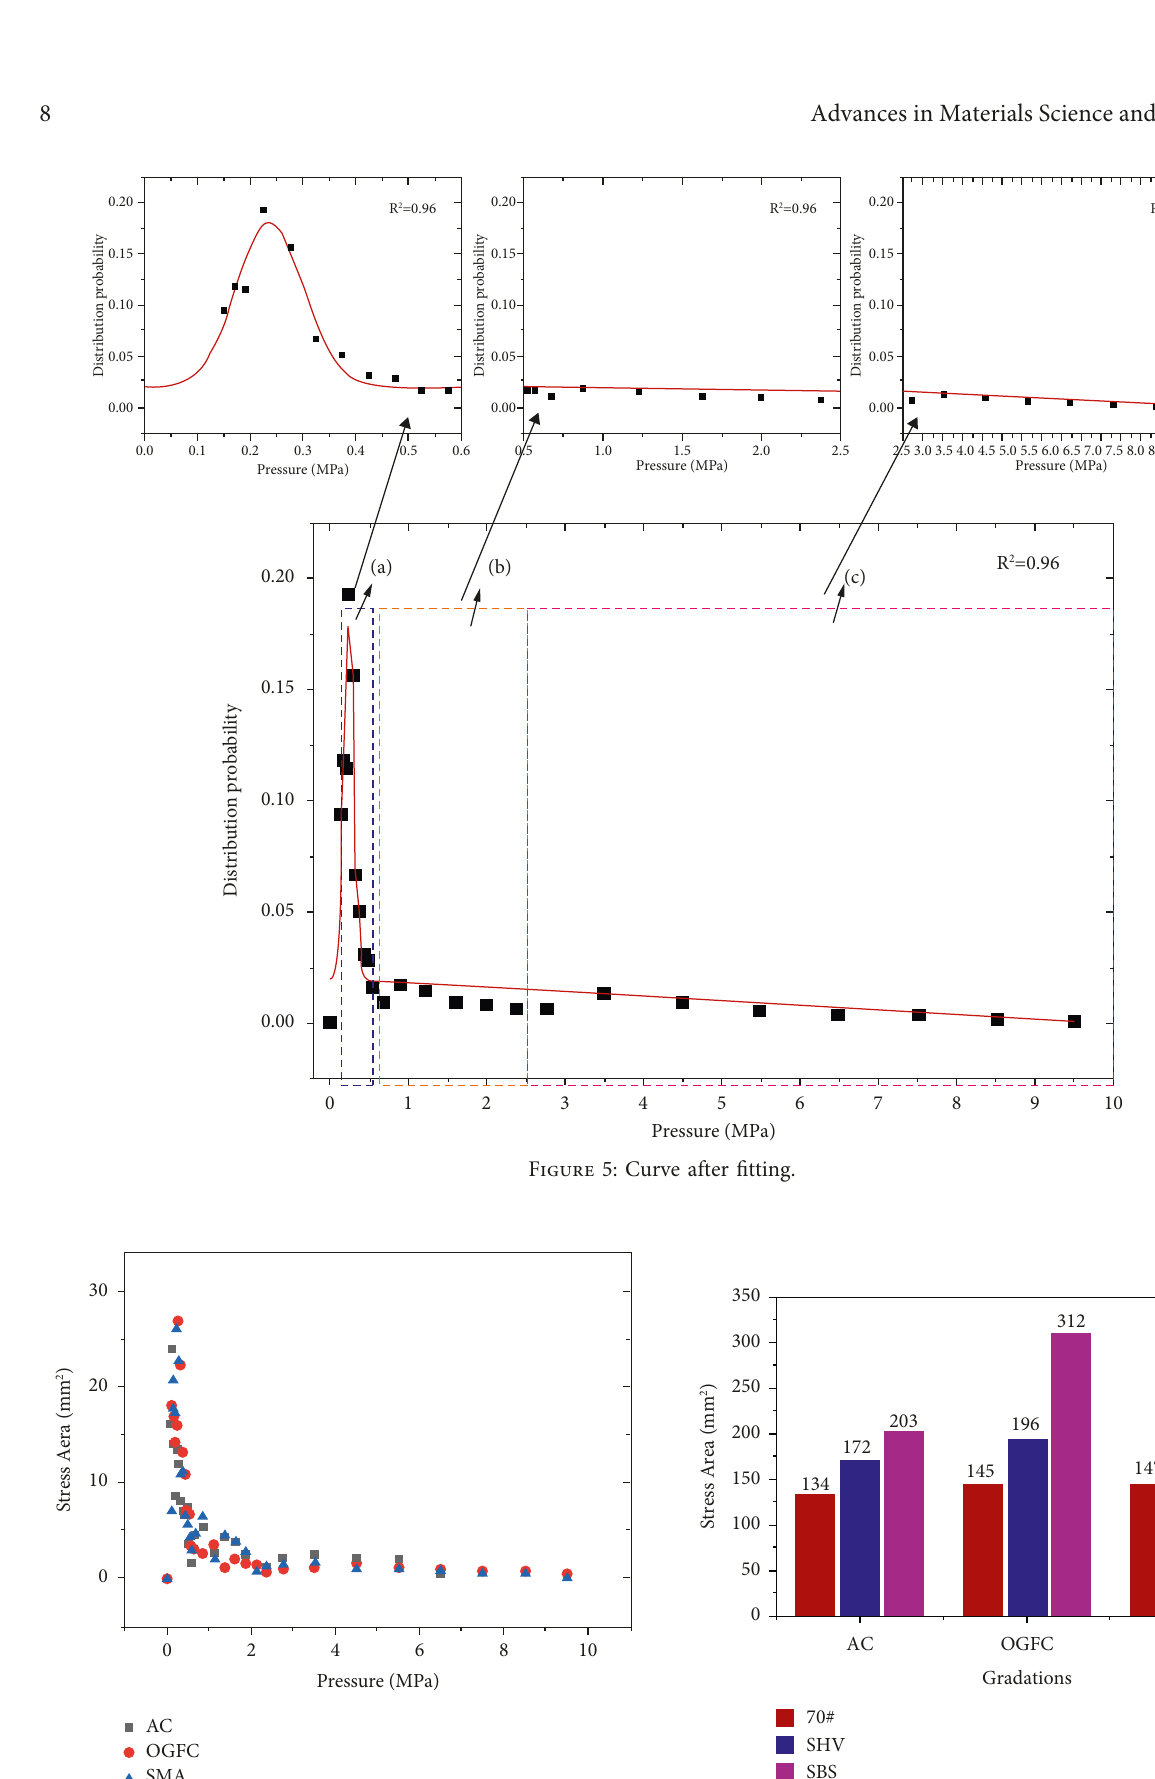
Figure 6: Stress distribution of SHV asphalt mixture. Figure 7: The contact area of different